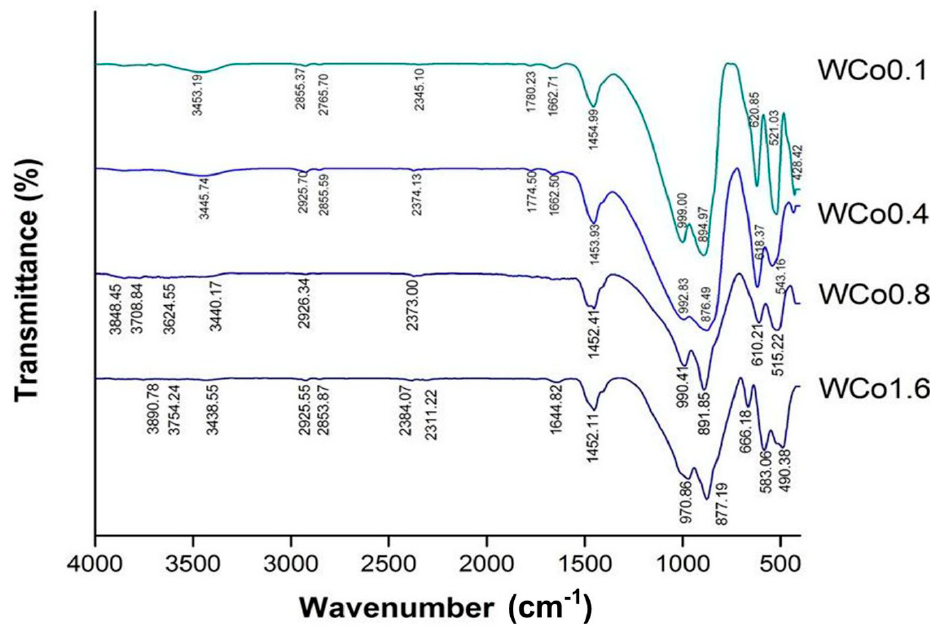
Figure 4. Fourier transformation infrared spectroscopy (FTIR) Spectrum of Co x Mg (2 − x ) SiO 4 ( x = 0.1, 0.4, 0.8, 1.6) samples synthesized by mirror waste calcined at 1000 °C for 2 h.